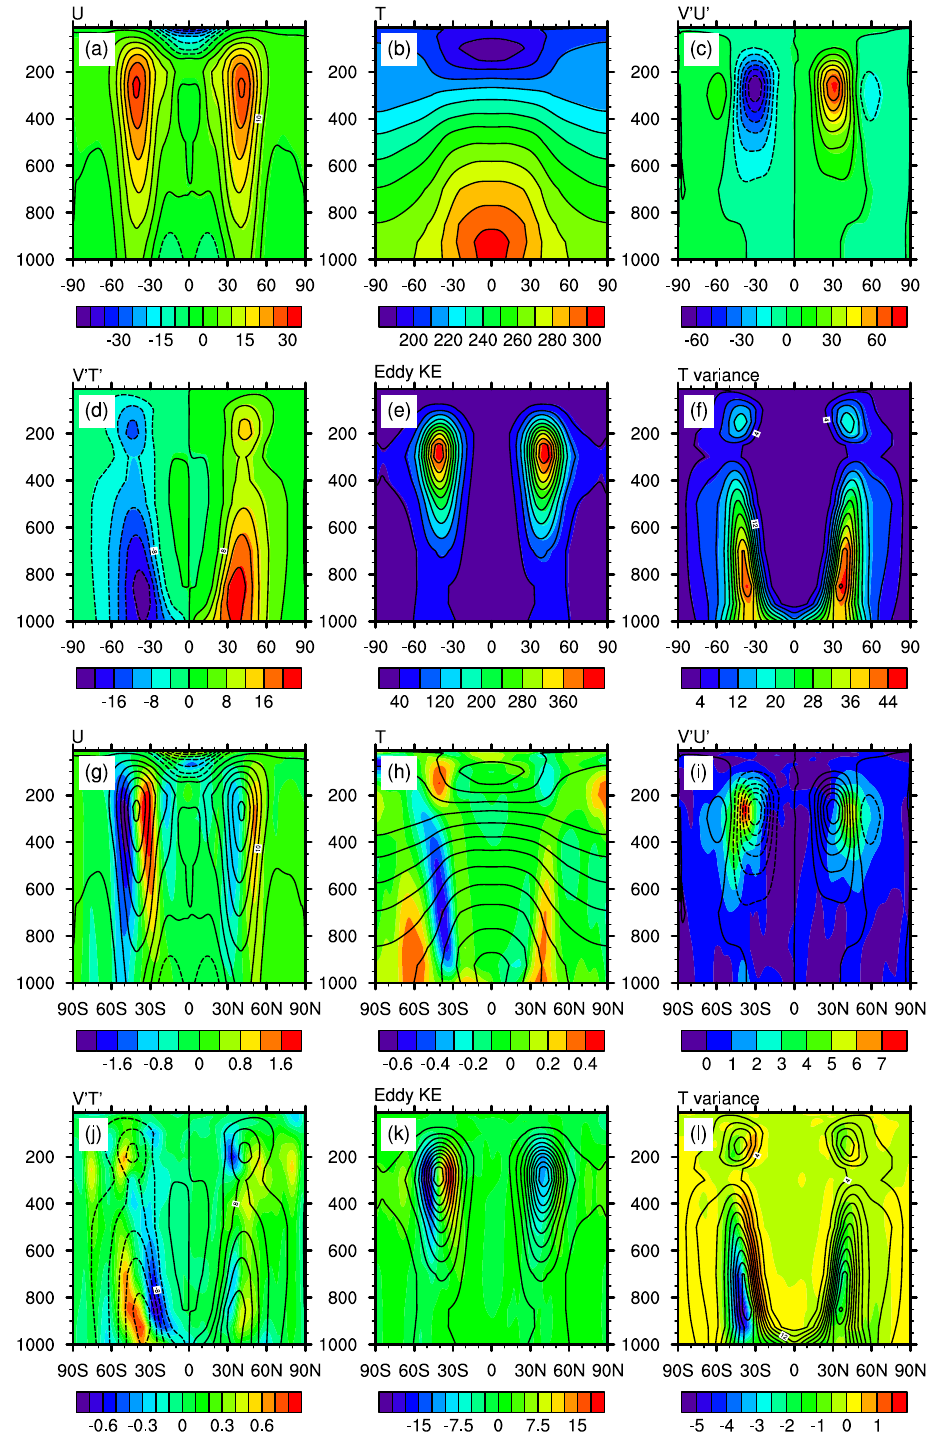
Figure 5. The 1000-day time-zonal averaged zonal wind speed ( U ), temperature ( T ), momentum flux ( U (cid:48) V (cid:48) ), heat flux ( V (cid:48) T (cid:48) ), eddy kinetic energy and temperature variance in the Held–Suarez test. Panels (a) – (f) – shading shows a reduced grid solution with variable resolution in latitude; contours show a regular grid solution with constant latitudinal resolution. Panels (g) – (l) – shading shows the difference between regular and reduced grid solutions with constant resolution in latitude (regular minus reduced); overlaid contours depict the regular grid